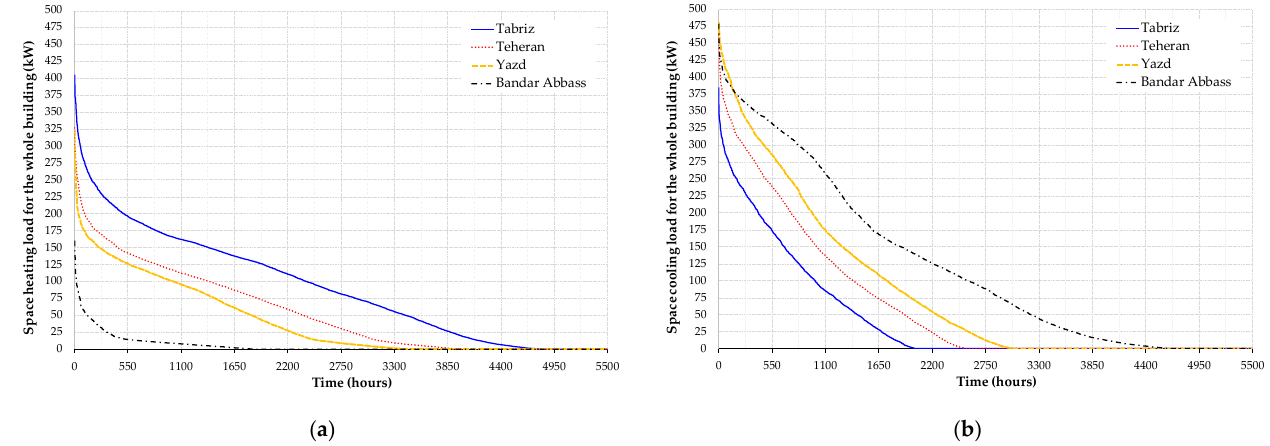
Figure 5. Space ( a ) heating and ( b ) cooling load-duration diagram associated with the whole building for the east-west orientation cases.